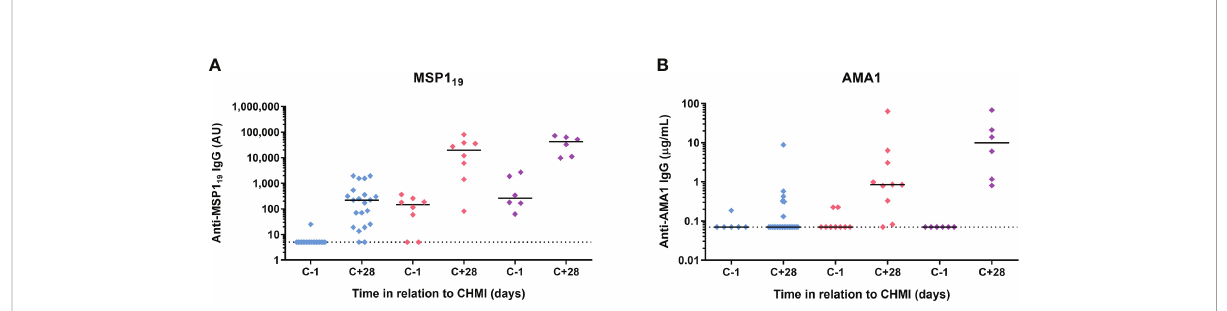
FIGURE 7 Induction of serum antibody responses to merozoite antigens during CHMI. (A) Serum anti-MSP1 19 total IgG ELISA was conducted on samples from participants for primary (n=19 at C-1; n=21 at C+28), secondary (n=8) and tertiary (n=6) CHMI. Sera from the pre-CHMI (C-1) and 28 days post-CHMI (C+28) time points were tested. (B) Serum anti-AMA1 total IgG as measured by standardized ELISA on samples from participants for primary (n=6 at C-1; n=24 at C+28), secondary (n=9 at C-1; n=10 at C+28) and tertiary (n=6) CHMI. Samples colour coded as per previous fi gures. Individual data points and median are